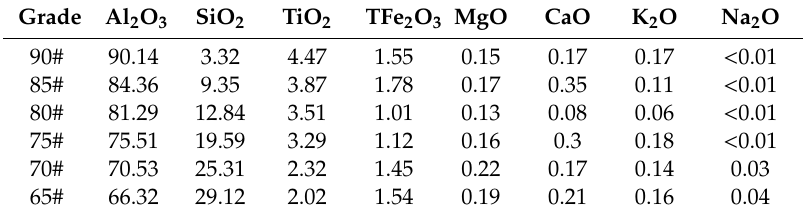
Table 1. Main chemical composition of calcined bauxite.